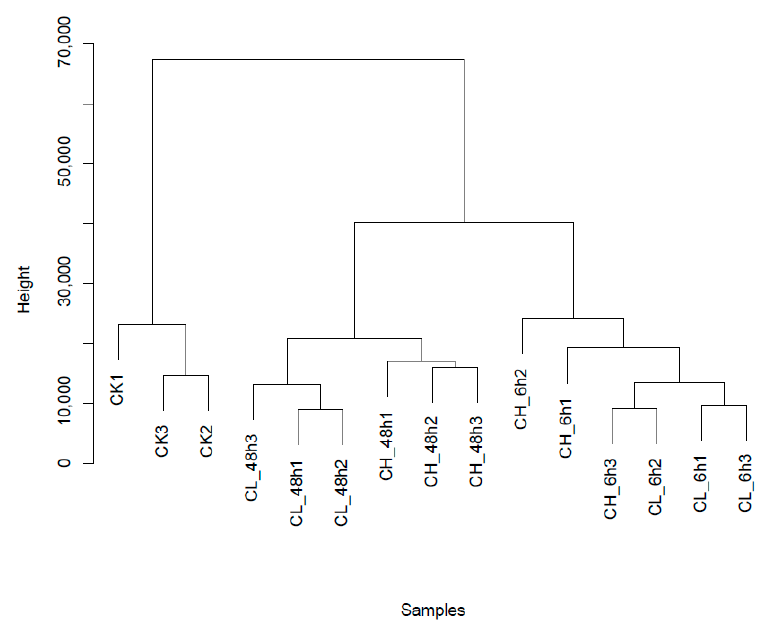
Figure 3. Cluster tree involving all samples. The distances of the expressed gene are calculated by the Euclidean method. Meanwhile, the algorithm of the sum of squares of deviations is used to calculate the distance between samples so that a cluster tree can be built. The Y axis means the height in the cluster tree. When samples have similar height values, they can be easily gathered. CK: Control; CH: Chlorpyrifos; CL: Clothianidin; 6 and 48 h: treatment with Chlorpyrifos or Clothianidin after 6 or 48 h.